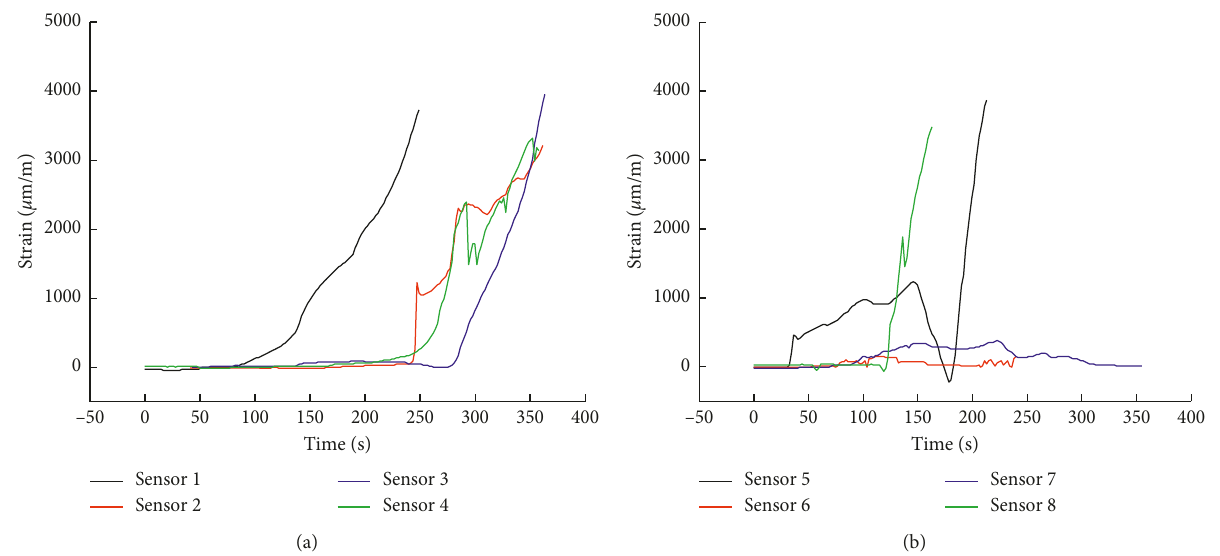
Figure 4: The grating strain-time curve at 10mm from the roadway wall: (a) the strain-time curve of 1–4 FBG sensors and (b) the strain- time curve of 5–8 FBG